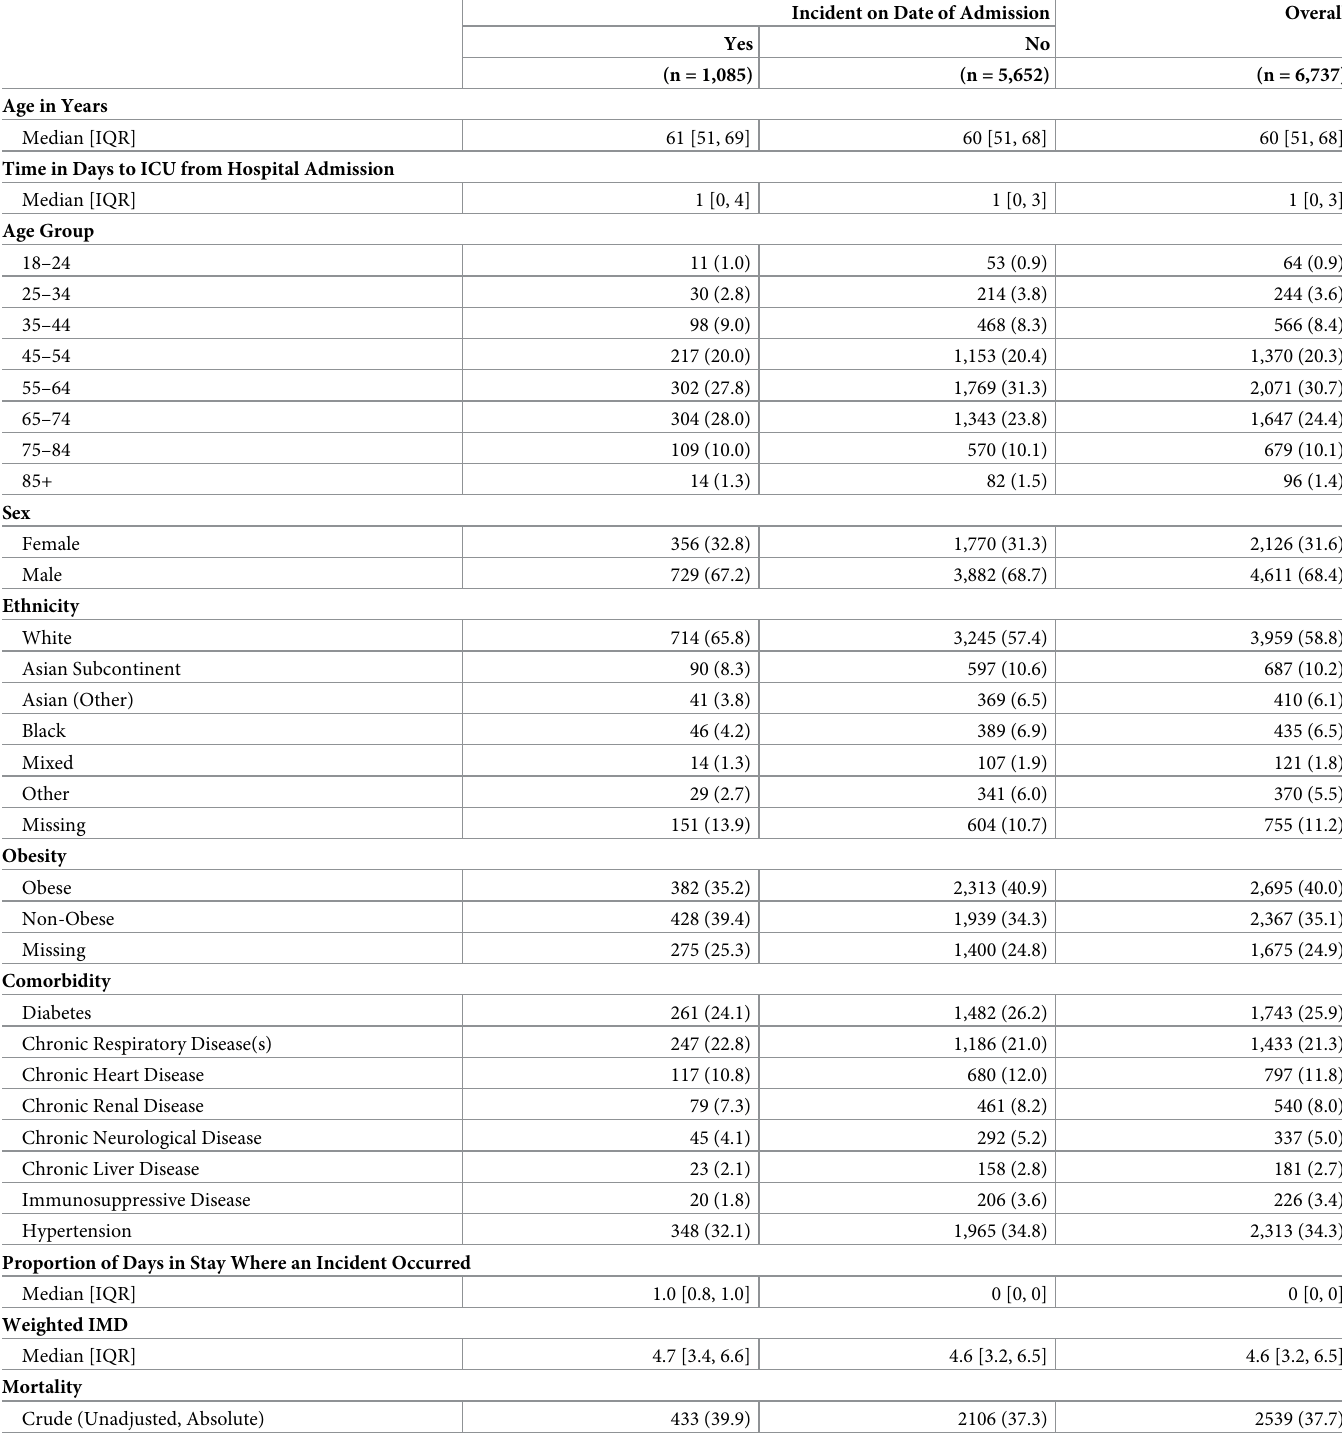
Table 1. Characteristics of the study cohort stratified by whether there was a serious operational problem occurring on their date of admission, in their admitting